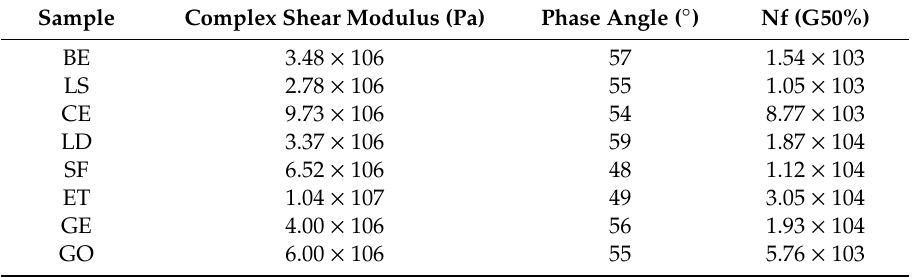
Table 3. Complex shear modulus, phase angle, and Nf (G 50% ) of corresponding mastics at 10 Hz and 20 ◦